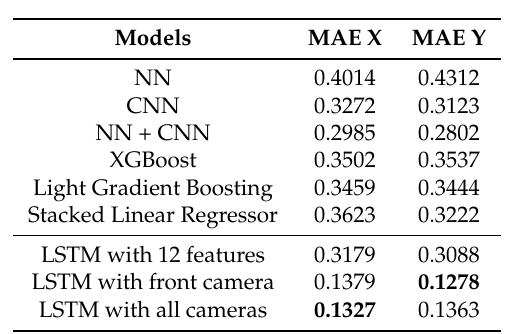
Table 2. MAE comparison. Compared with the values along the x -axis and the y -axis, the values along the z -axis are small enough to be ignored; thus, the MAE result along the z -axis is omitted.